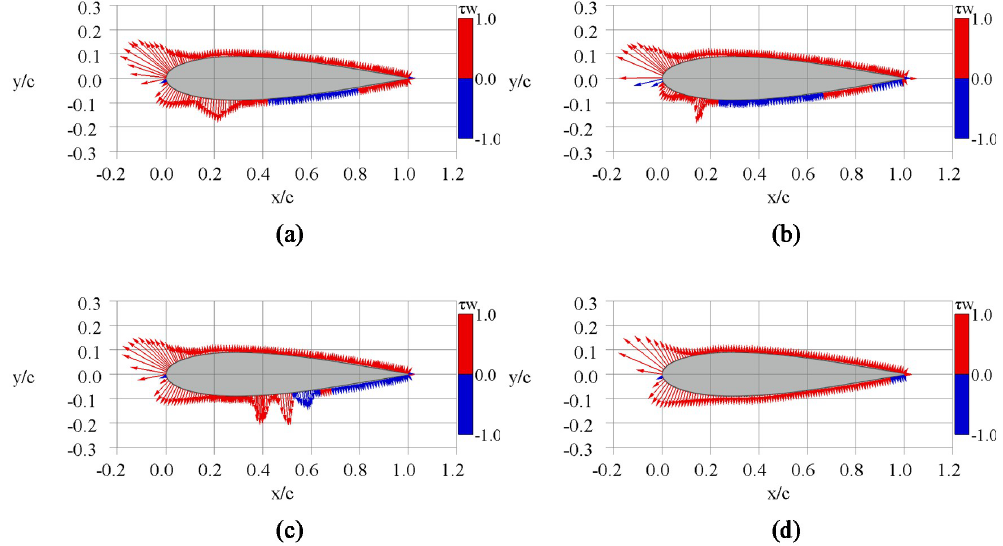
Figure 18. Wall shear stress, or surface friction, distributions on the blade cross-section of m = 25 in each rotor case with different cross-section arms: ( a ) airfoil arm rotor, ( b ) rectangular arm rotor, ( c ) circular arm rotor, and ( d ) armless rotor. The values of the color bars showing the wall shear stress τ w have an arbitrary unit expressing only the direction of the wall shear stress.